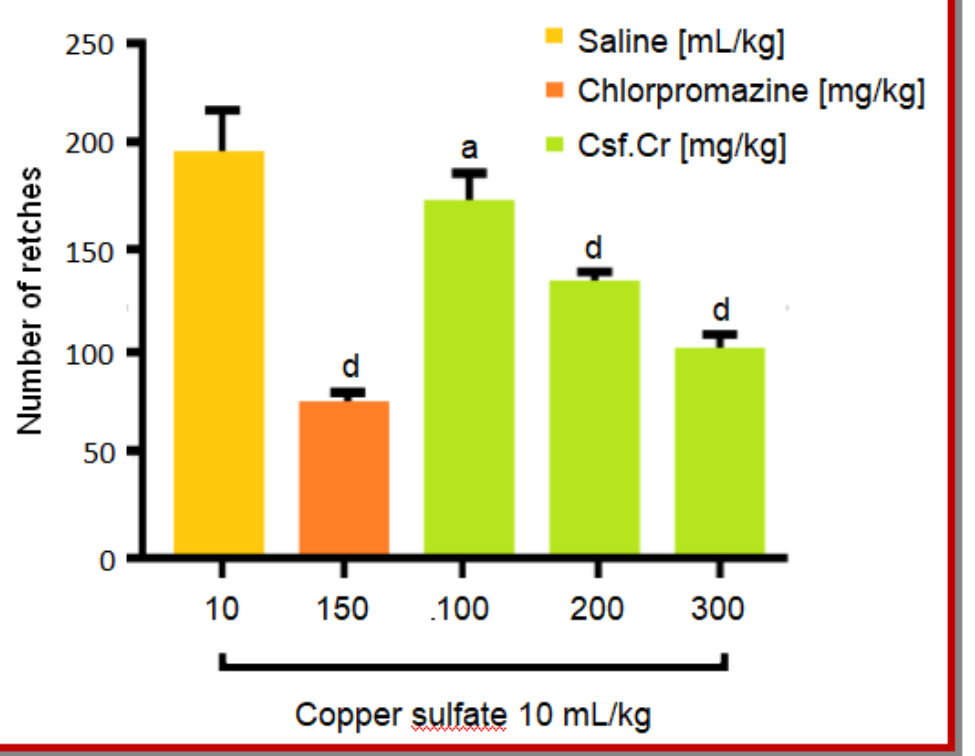
Figure 5: Dose dependent inhibitory effect of Crude extract of C.siliqua Linn on copper sulfate induced retches in chicks in com- parison of chlorpromazine. a (p<0.05), d (p< 0.0001) were considered statistically significant followed by One Way Analysis of Variance (ANOVA).